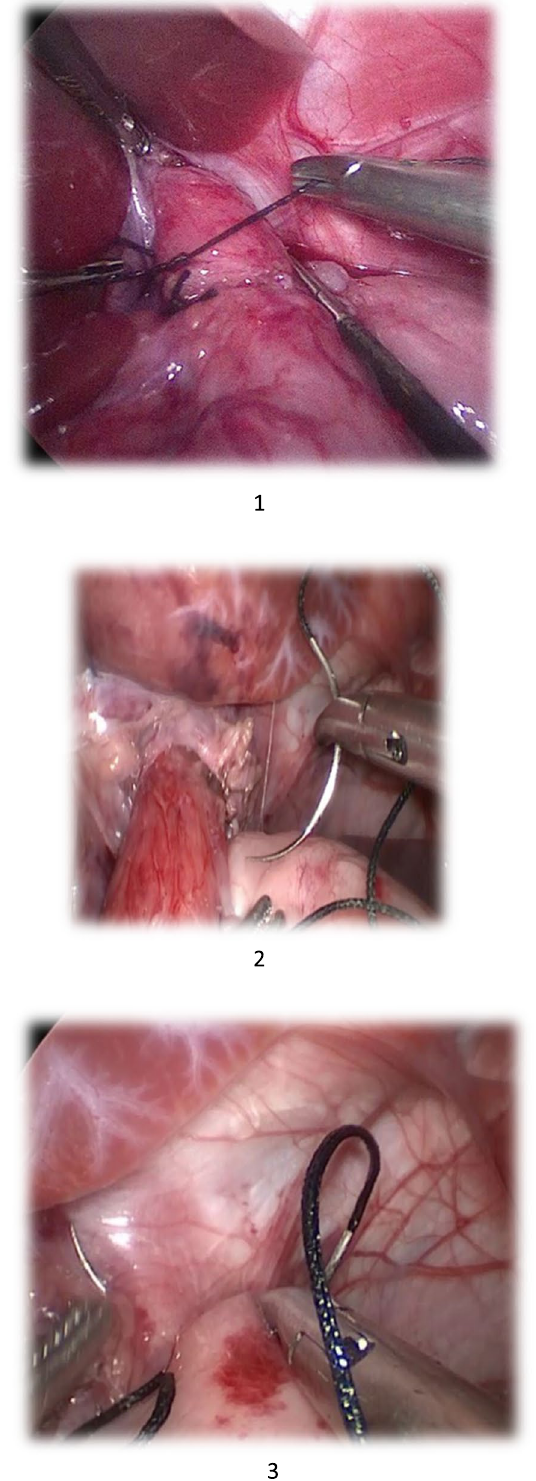
Fig. 3 1 Posterior esophago-cardiopexy. 2 Accentuation of angle of His. 3 Fixation of the gastric fundus to the diaphragm